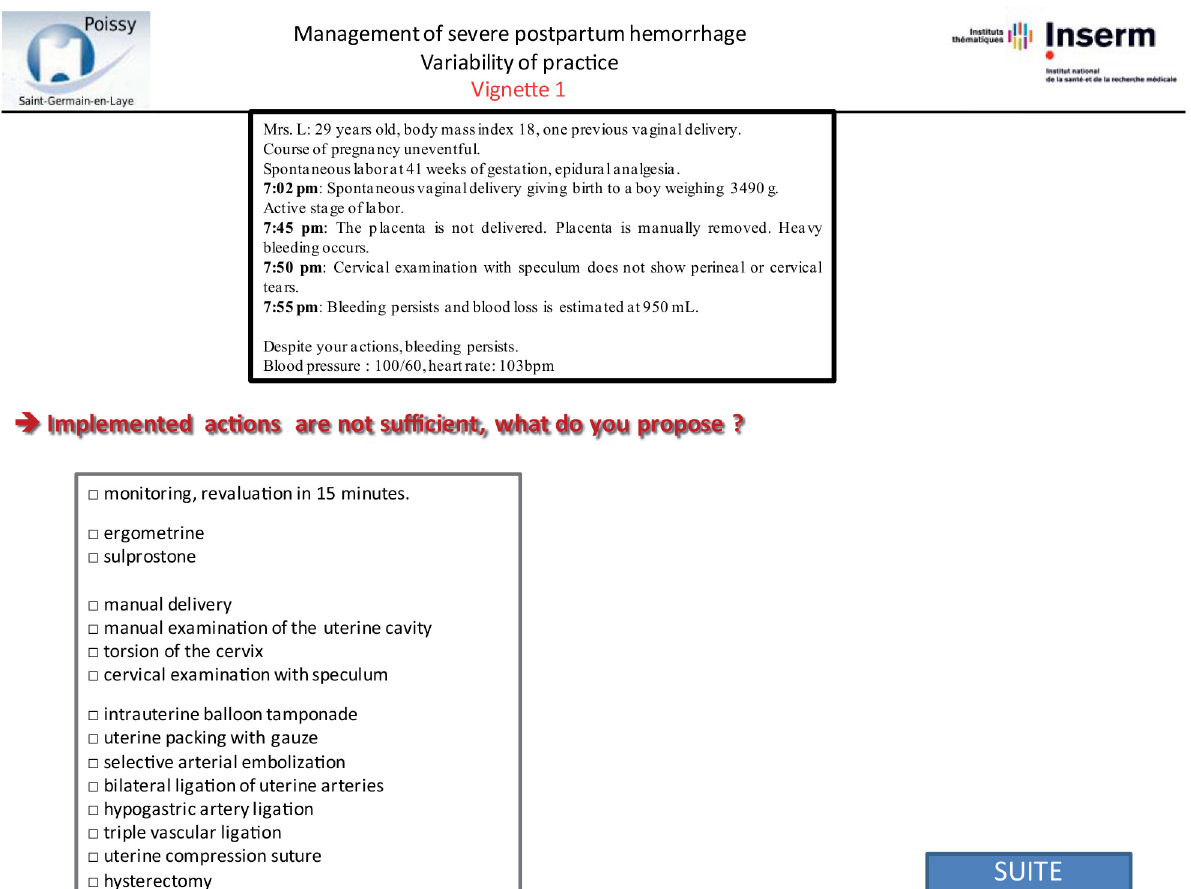
Fig 3. Step 3 of sample vignette. This figure corresponds to screenshot of the website: third and last step of the same vignette with the same closed-ended question.